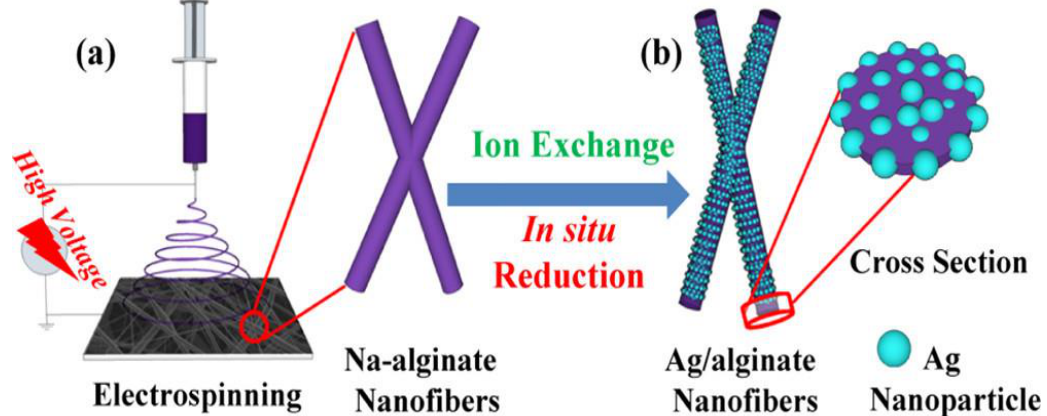
Figure 5. Schematic diagram illustrating the fabrication process of Ag/alginate nanofibers. ( a ) Na-alginate nanofibers prepared by electrospinning. ( b ) Ion-exchange and in situ reduction processes. Reprinted with permission from Ref. [124]. Copyright American Chemical Society, 2018.